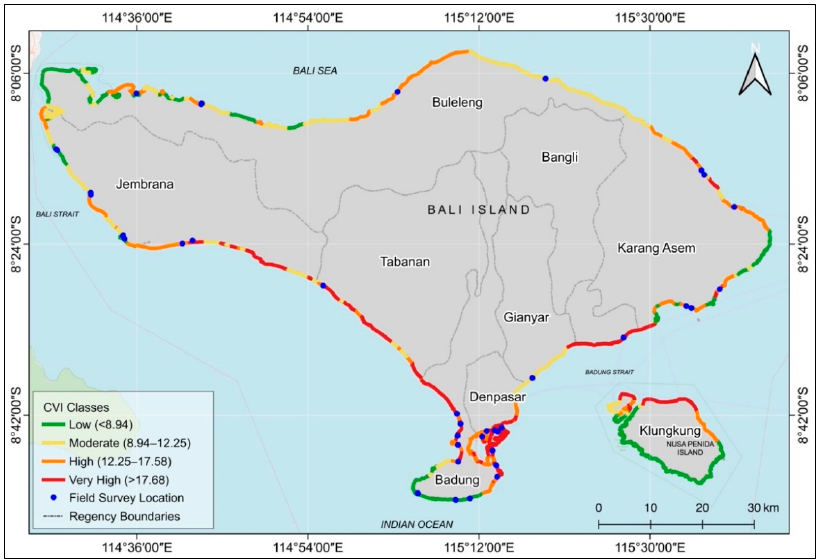
Figure 4. Sampling locations for model validation.